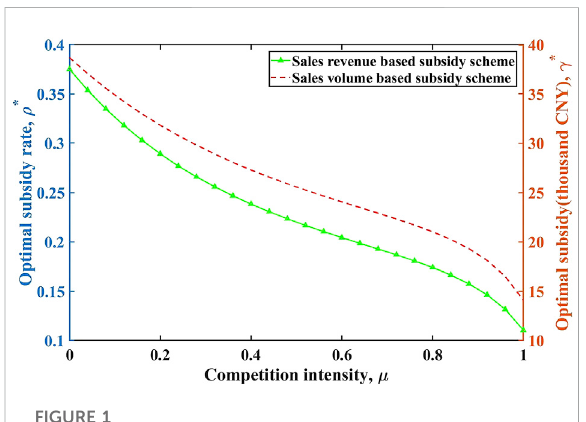
FIGURE 3 Comparison of fi rm 2 ’ s quantity under two different subsidy schemes.